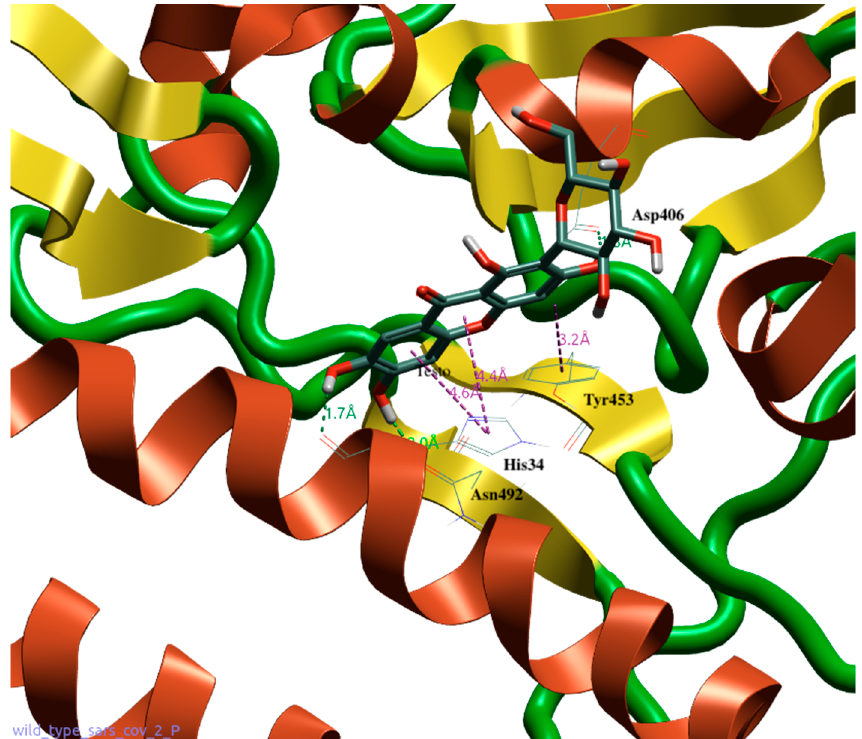
Figure 8. Docking position of MGF (1) in the binding interface between spike 1 (green and yellow) and ACE2 (red). Interaction with His34, Arg457, and His458. Water and accessory parts of spike and ACE2 were omitted for clarity.